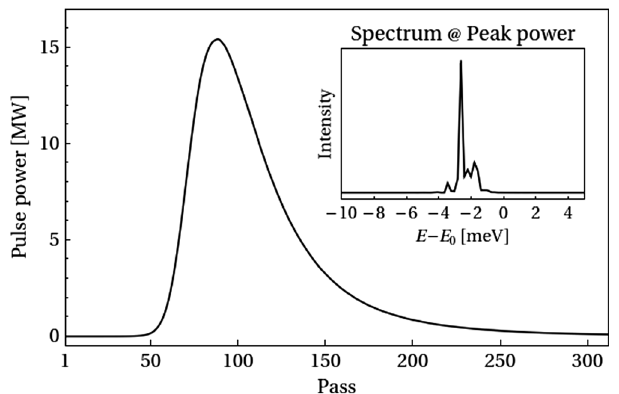
FIG. 9. X-ray beam spot at peak power. The root-mean-square 14 μ m and σ 12 μ m. The slight (rms) beam sizes are σ x ¼ y ¼ asymmetry, despite the symmetric cavity, is due to the Bragg crystal filtering acting only in the horizontal